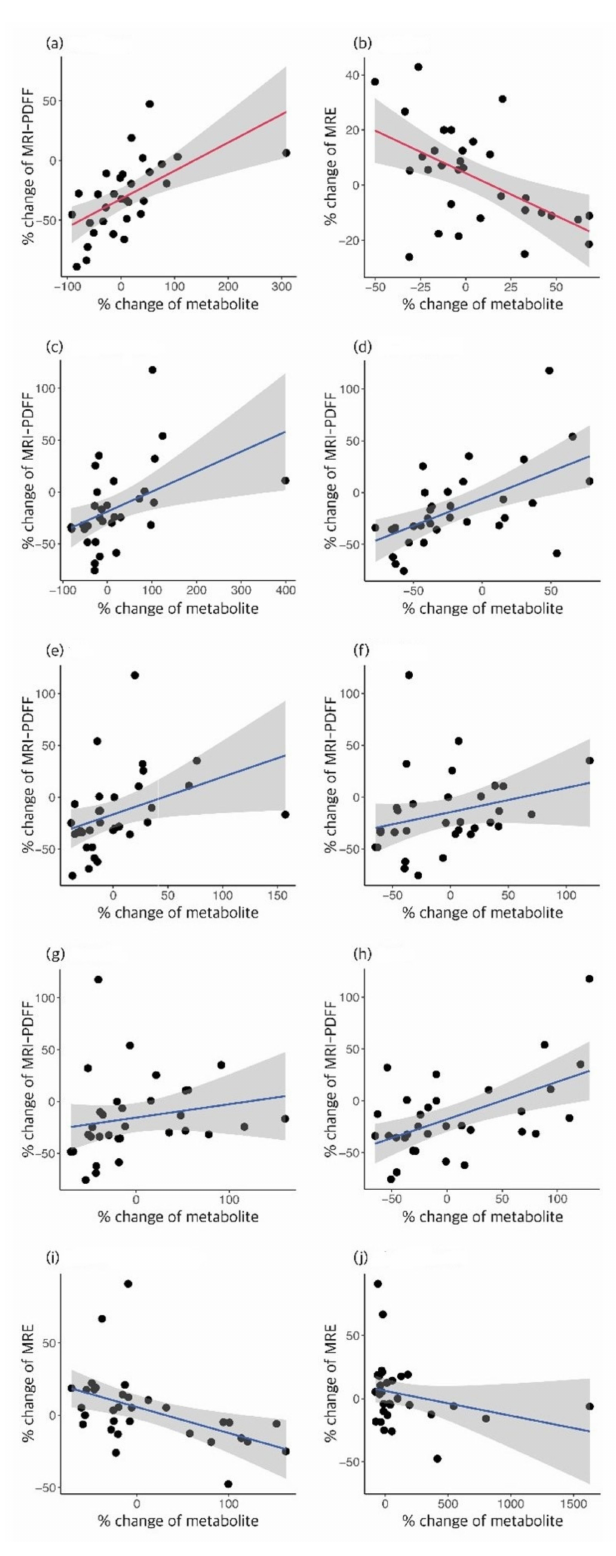
Figure 2. Linear regression analysis of the associated percent changes of the metabolite levels and MRI diagnostic values. Linear correlation of ( a ) xanthine with MRI-PDFF change and ( b ) choline with MRE change in ezetimibe + statin group. Linear correlation of ( c ) TG 20:5_36:2, ( d ) TG 18:1_38:6, ( e ) C2, ( f ) FA 18:2, ( g ) FA 18:1, and ( h ) DHA with MRI-PDFF change, and ( i ) HexCer (d18:2/16:0) and ( j ) hippuric acid with MRE change in the statin group. The shaded area corresponds to the 95% confidence